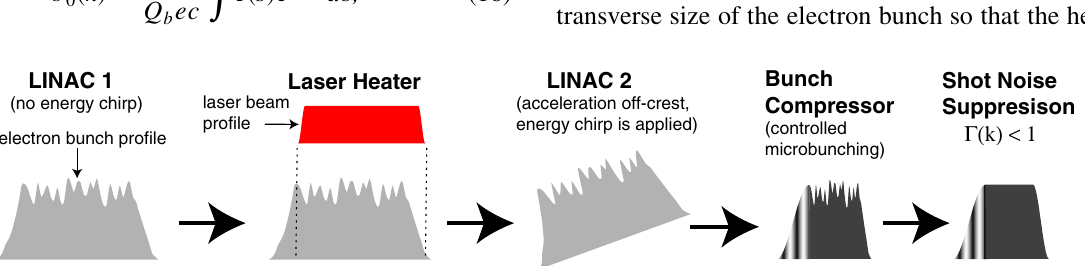
FIG. 14. The schematic illustration of a possible formation of the quiet bunch with a high current gradient at the bunch